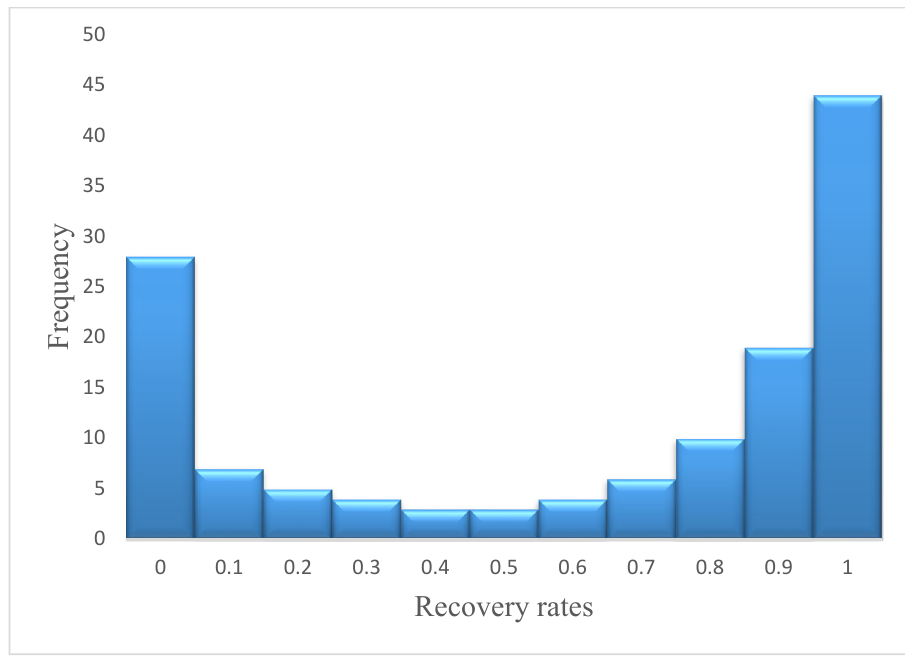
Figure 1. Recovery rate distribution.